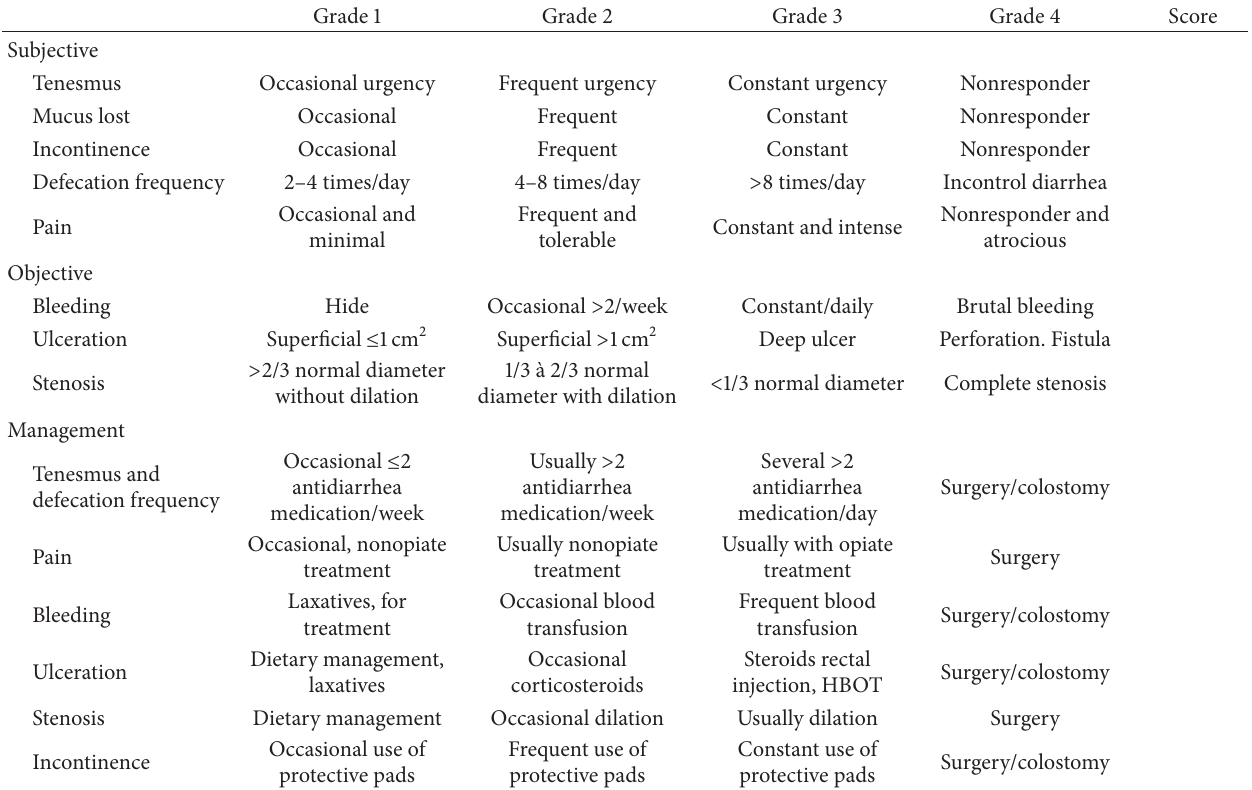
Table 2: SOMA-LENT Scale